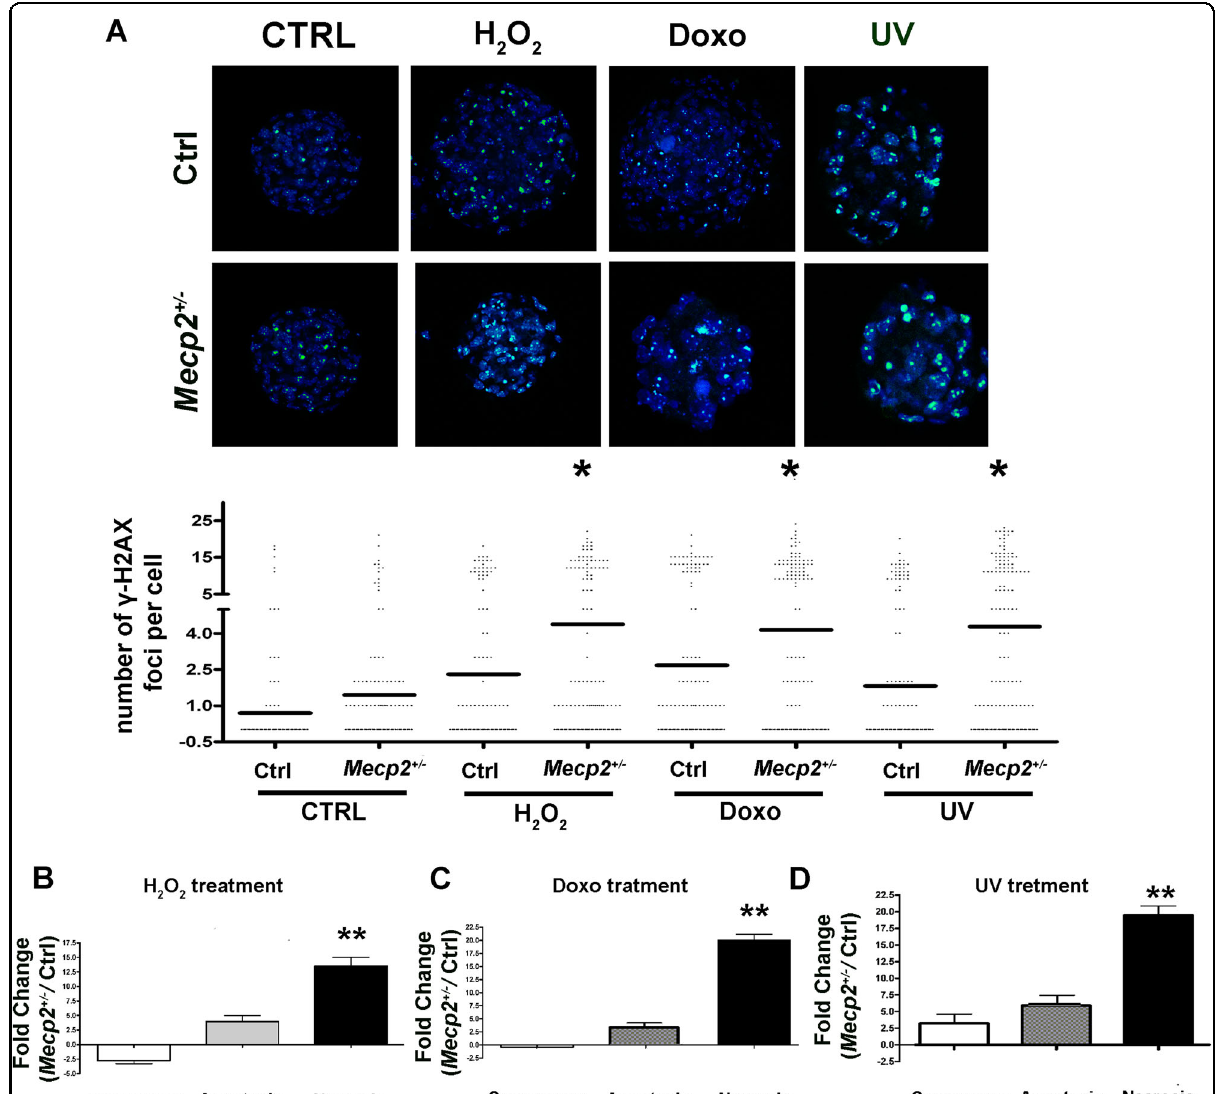
Fig. 3 DNA damage, senescence, apoptosis, and necrosis. a Photos show the merging of cells stained with anti-H2AX (green) and DAPI (blue). Representative microscopic fi elds are depicted. The column scatter plot indicates the degree of H2AX phosphorylation that was determined by counting the number of γ -H2AX immuno fl uorescent foci per cell. The foci number was determined for 200 cells. Each dot represents a single cell. Horizontal bars indicate the mean value for each category ( Mecp2 + / − and control NSCs; n = 5 biological replicates; * p < 0.05). b , c , d The DNA damage levels following genotoxic treatments with hydrogen peroxide, doxorubicin, and UV irradiation, respectively. For every condition, the degree of DNA damage was determined by counting γ -H2AX foci. Changes in the level of senescence, apoptosis, and necrosis in Mepc2 + / − NSCs were compared with the control cultures. The data are expressed in fold change ( n = 5 biological replicates; * p < 0.05, ** p <